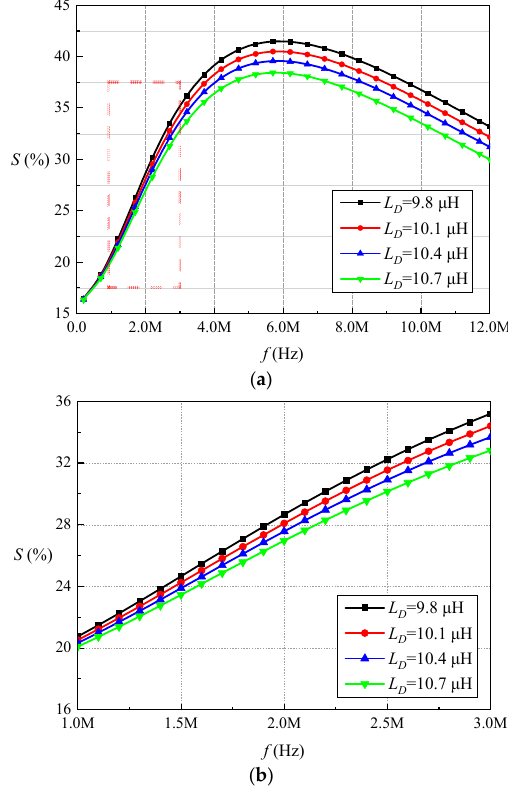
Figure 12. Relationship between the detection sensitivity S and excitation frequency f when the coin was in the corner area of detection coil: ( a ) Broad frequency band; ( b ) Zoomed details of the red dotted square part in Figure 12a.